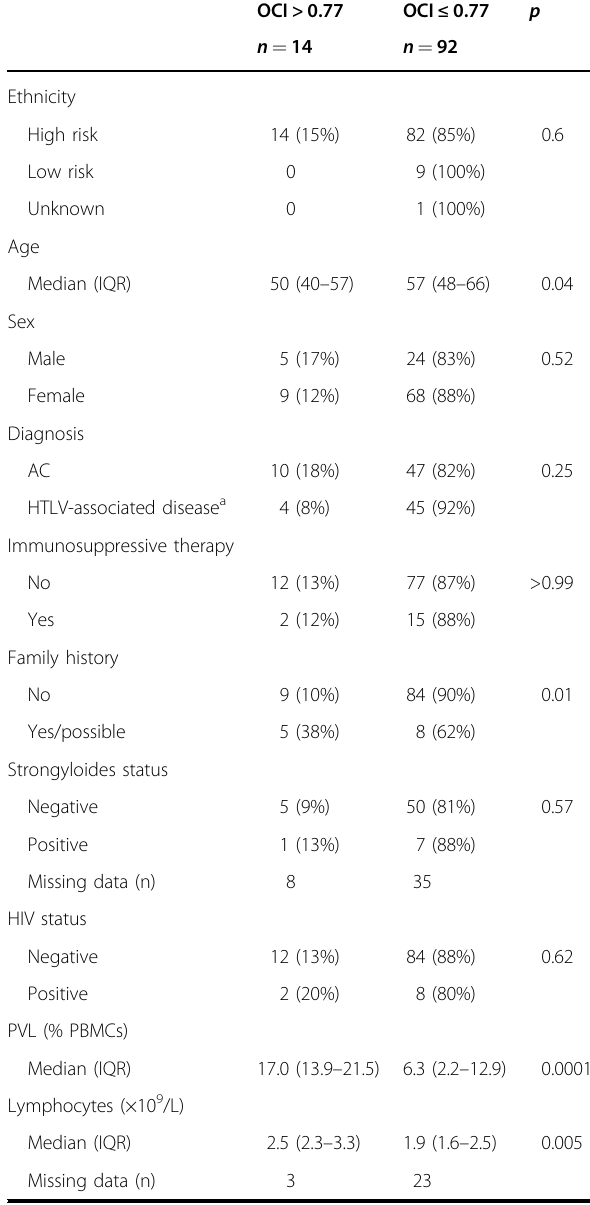
Table 2 Demographic and clinical data from the screening group, subdivided by OCI- fl ow